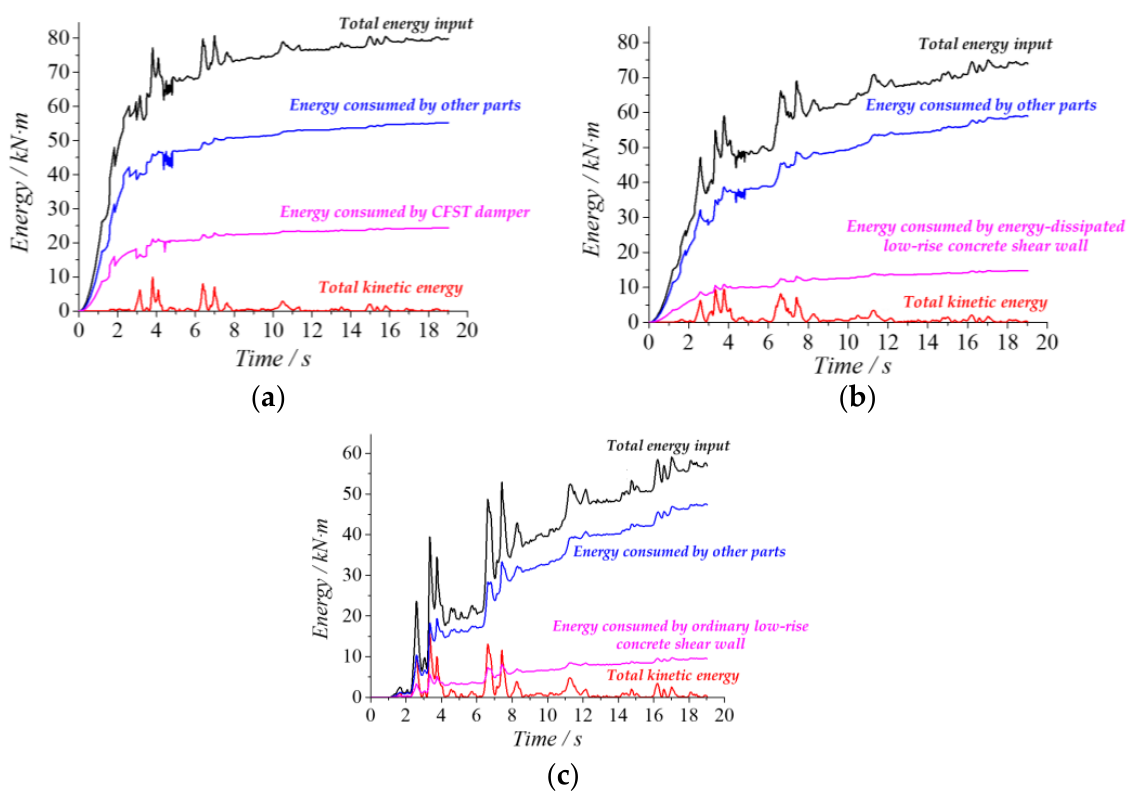
Figure 22. Energy distribution of three structures under EL-Centro wave. ( a ) Energy distribution of JG-1; ( b ) energy distribution of JG-2; ( c ) energy distribution of JG-3.